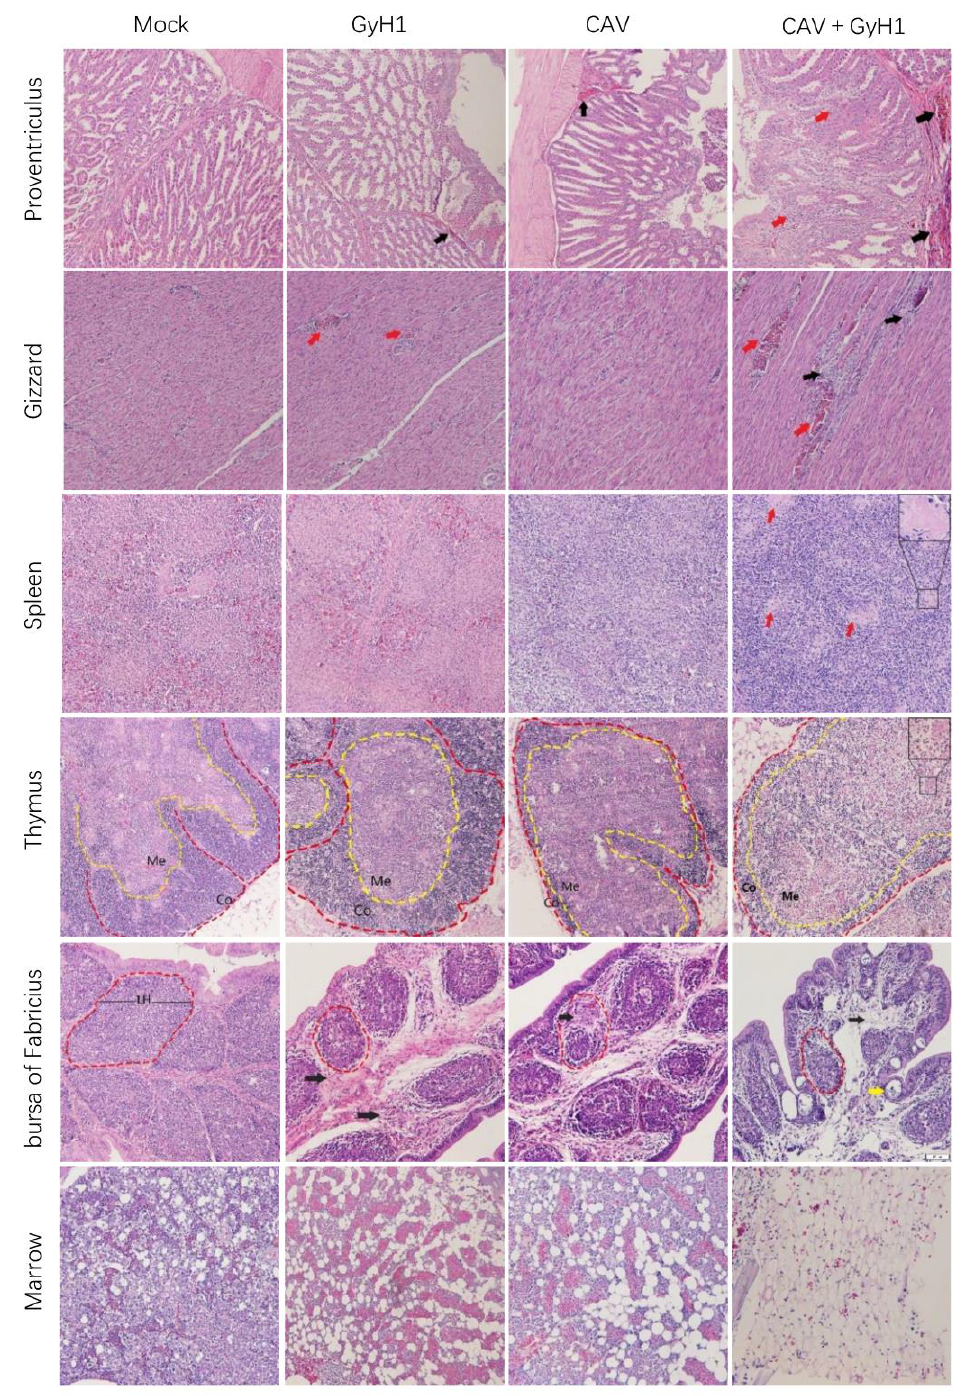
Figure 6. Histopathological examination of immune and digestive organs (HE staining, 20 × ). Mu- cosal lamina propria exudation of erythrocytes in the proventriculus (black arrows), and structural disturbances resulting from necrosis of glandular tubule cells (red arrows); muscular hemorrhage (red arrows) and myofiber necrosis (black arrows) in the gizzard; splenic lymphocytes were lost, and germinal centers were enlarged (red arrows); decreased thymic cortical area (Co) and enlarged medullary substance region (Me); bursal lymphoid follicles (LH) are miniaturized with connective tissue hyperplasia (black arrow) and lymphatic follicular emptying (yellow arrow); adipocytes replace myeloid cells in the bone